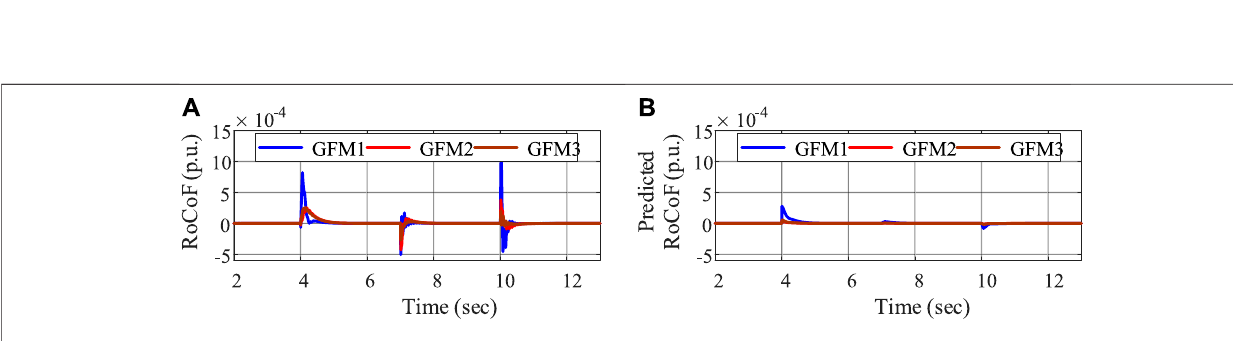
Frontiers in Energy Research |